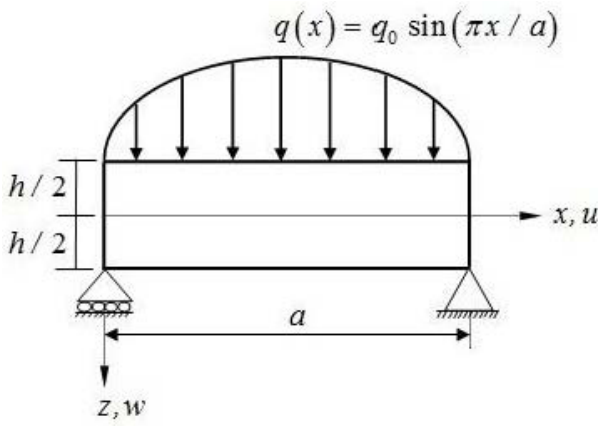
Figure 2: Simply supported plate in xz plane subjected to sinu- soidally distributed